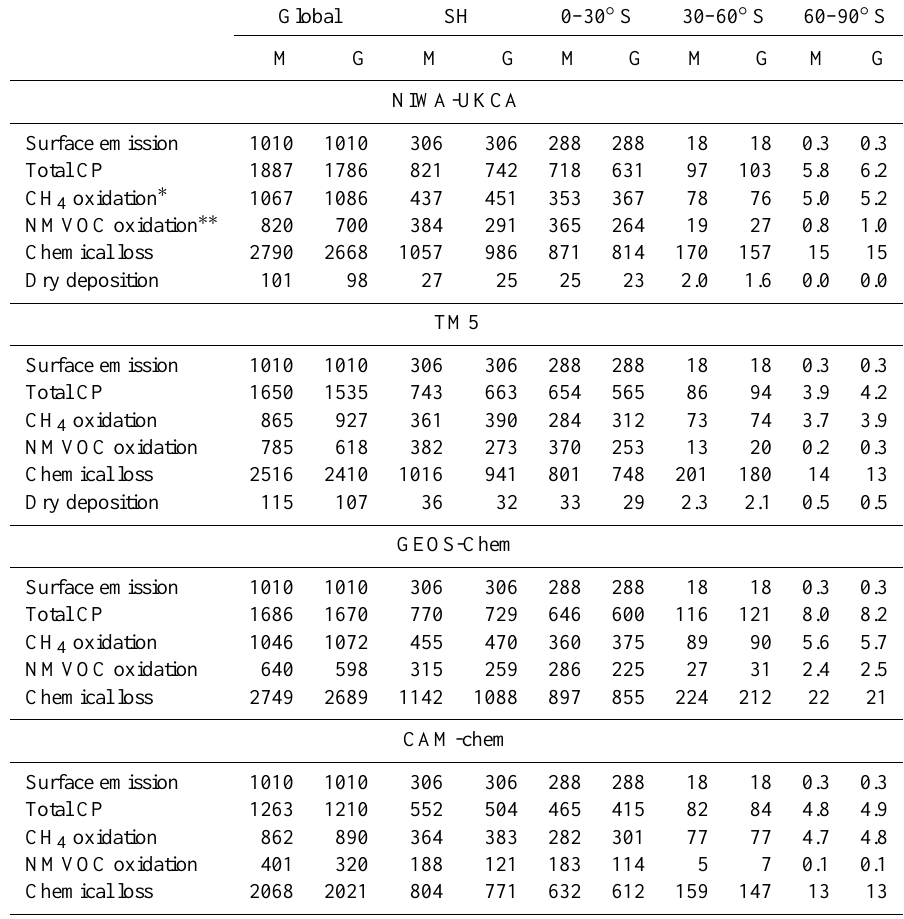
Table 4. Tropospheric CO budget for 2004. Units inTgCOyr −